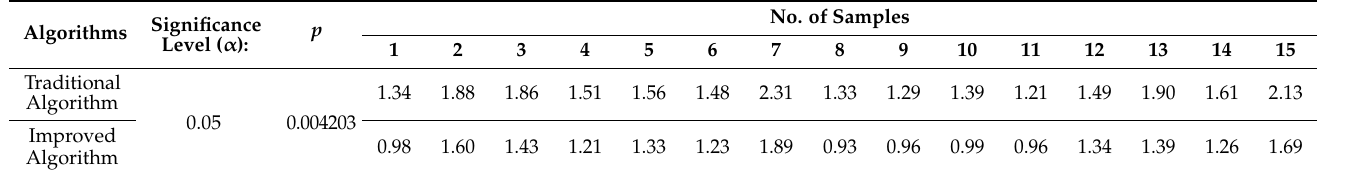
Table 3. Statistical test on the improved K-means algorithm and the original